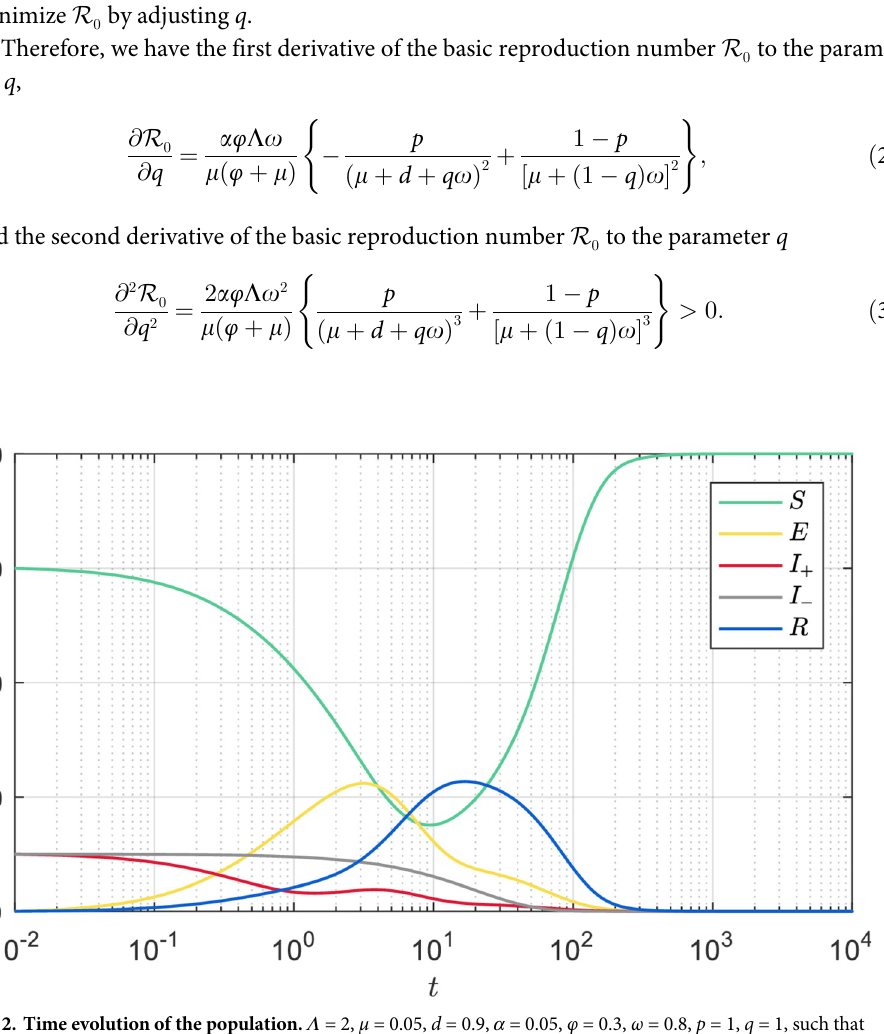
Fig 2. Time evolution of the population. Λ = 2, μ = 0.05, d = 0.9, α = 0.05, φ = 0.3, ω = 0.8, p = 1, q = 1, such that